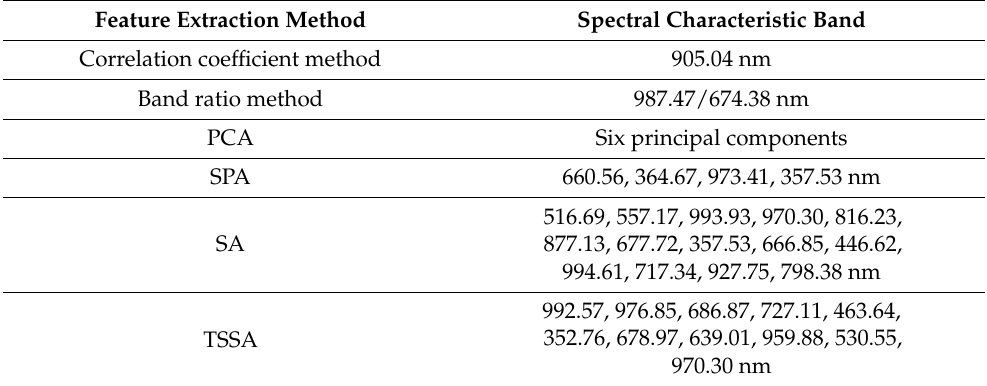
Table 1. Feature bands obtained using the six feature extraction methods.